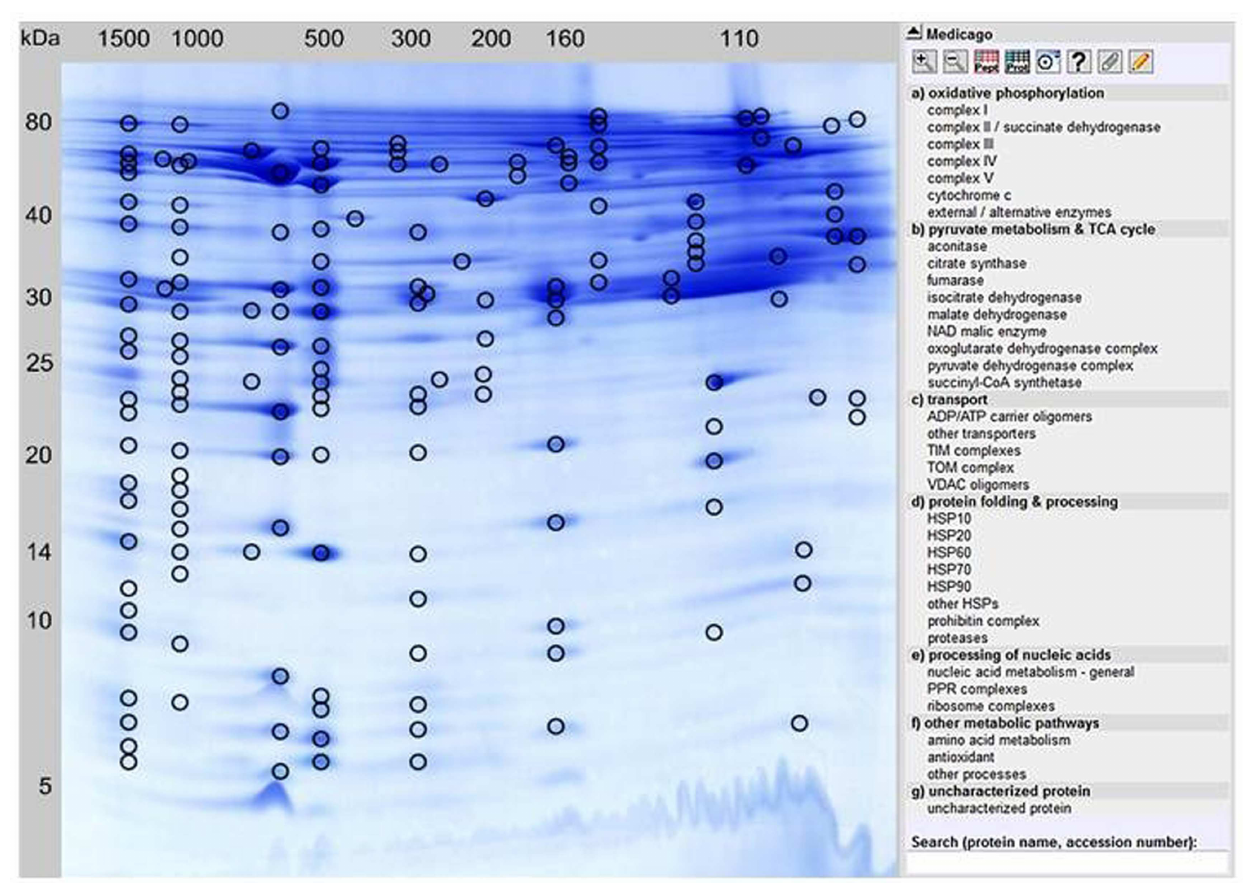
with the protein identification of the highest MASCOT score.The menu to the right lists classes of physiological functions for mitochondrial protein complexes. By clicking on the selected protein complex in this menu, accessions of all included individual proteins as well as the corresponding protein spots in the gel image are highlighted. Alternatively, a protein can be found in GelMap by the Search tool at the bottom to the